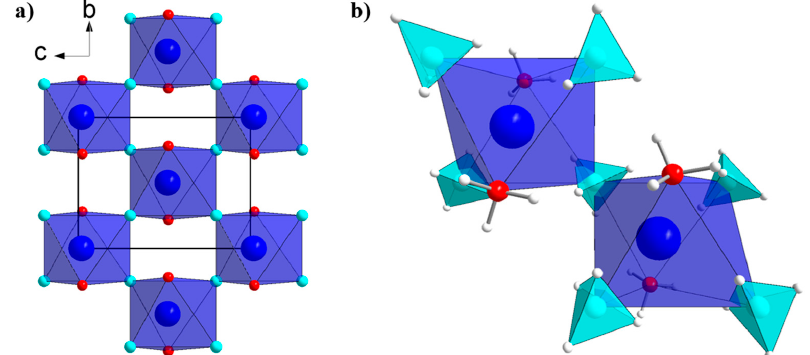
Figure 4. ( a ) Crystal structure of Ba(BH 4 ) 2 · 2NH 3 (space group Pnc 2), forming layers in the bc plane. Hydrogen is omitted for clarity. ( b ) Local coordination geometry of Ba 2+ with BH 4 − and NH 3 groups in an octahedral geometry. Color scheme: Ba (blue), B (turquoise), N (red), H (white). Ba(BH 4 ) 2 · NH 3 crystallizes in an orthorhombic unit cell with space group symmetry P 2 1 2 1 2 1 and unit cell parameters a = 5.08626(8), b = 9.3761(2) and c = 12.9632(2) Å, see Figure 5a. The structure is